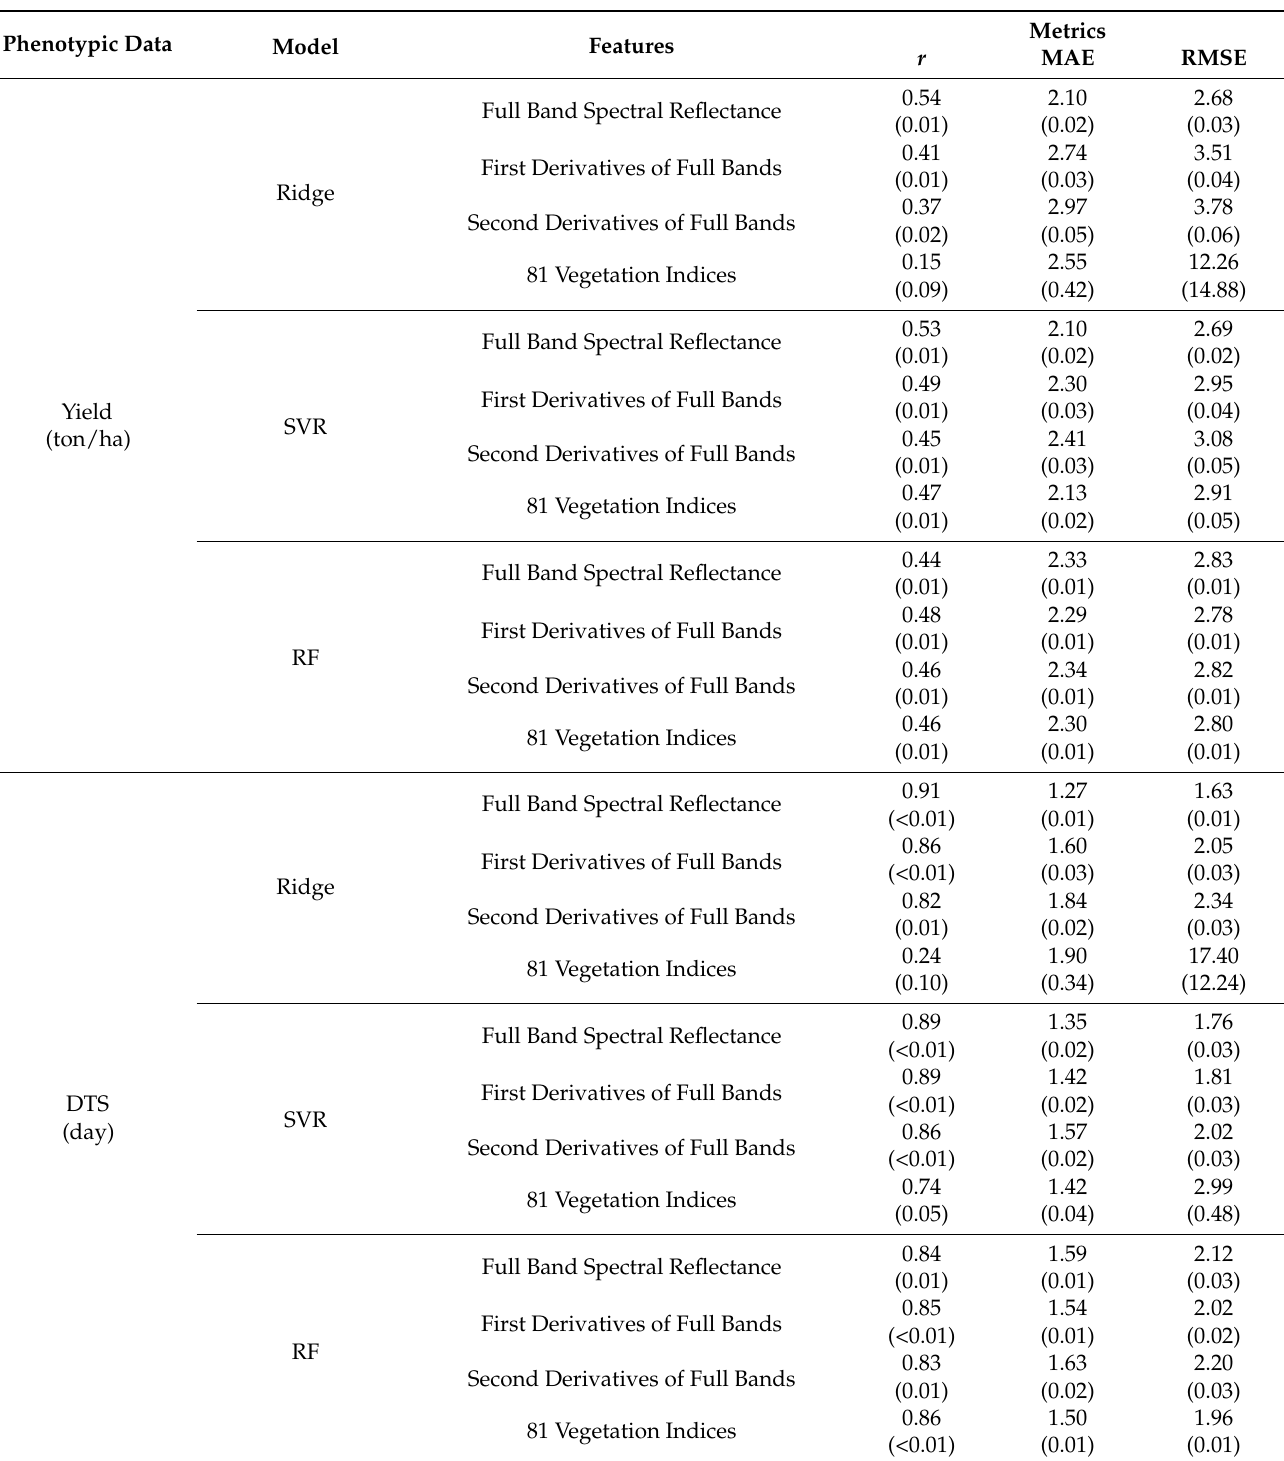
Table 3. Performance of the ridge, SVR, and RF models in maize yield and flowering time estimation using the combined 11-day features. The numbers outside the parenthesis show the averaged accuracies of the repeated four-fold cross-validation, and the numbers in the parenthesis are standard deviations of the repeated testing